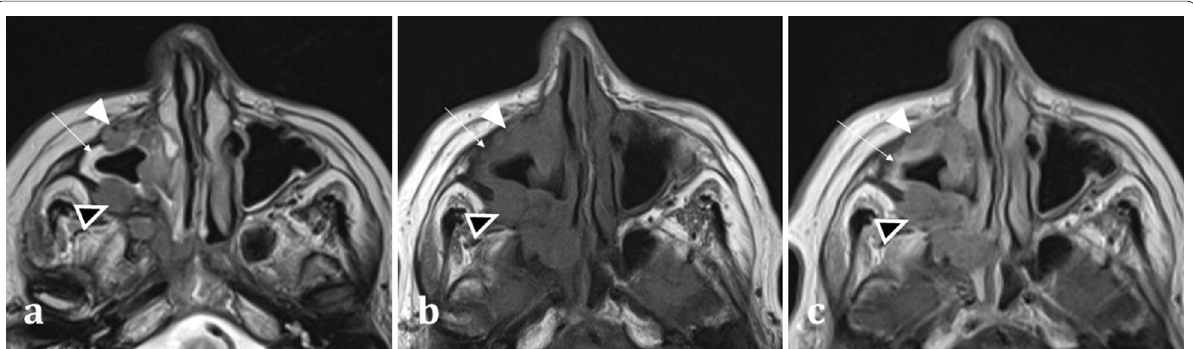
Fig. 5 Axial MRI images of a 66-year-old female patient with right maxillary sinus squamous cell carcinoma (SCC). She presented with symptoms of chronic rhinosinusitis for which a CT sinuses was performed (not shown) demonstrating unilateral maxillary sinus disease, suspicious for malignancy. Axial T2 weighted image ( a ) exhibits an isointense soft tissue lesion (white arrowhead) permeating and extending through the right maxillary sinus, which can be differentiated from the high T2 signal normal mucosa (arrow). Both the SCC (white arrowhead) and normal mucosa (arrow) are hypointense on T1W imaging ( b ). On T1W post-contrast imaging ( c ), the lesion demonstrates less enhancement (white arrowhead) compared to the adjacent hyperenhancing sinonasal mucosa (arrow) ( c ). Transpatial spread into the right pterygopalatine fossa is also identifiable on all sequences (black arrowheads with white